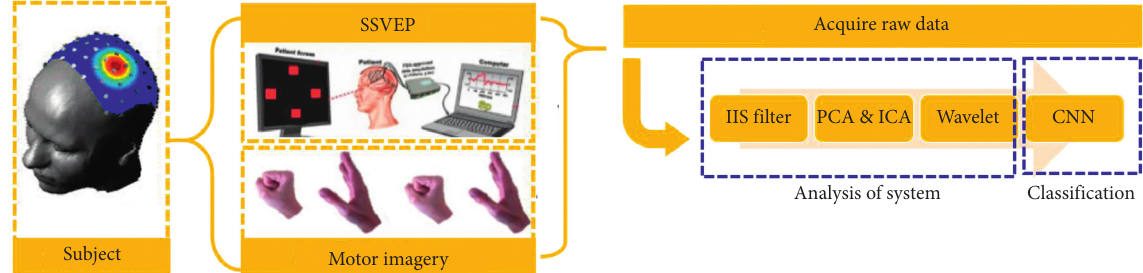
Figure 3: Schematic architecture of the experiment setup for the hybrid BCI system with MI and